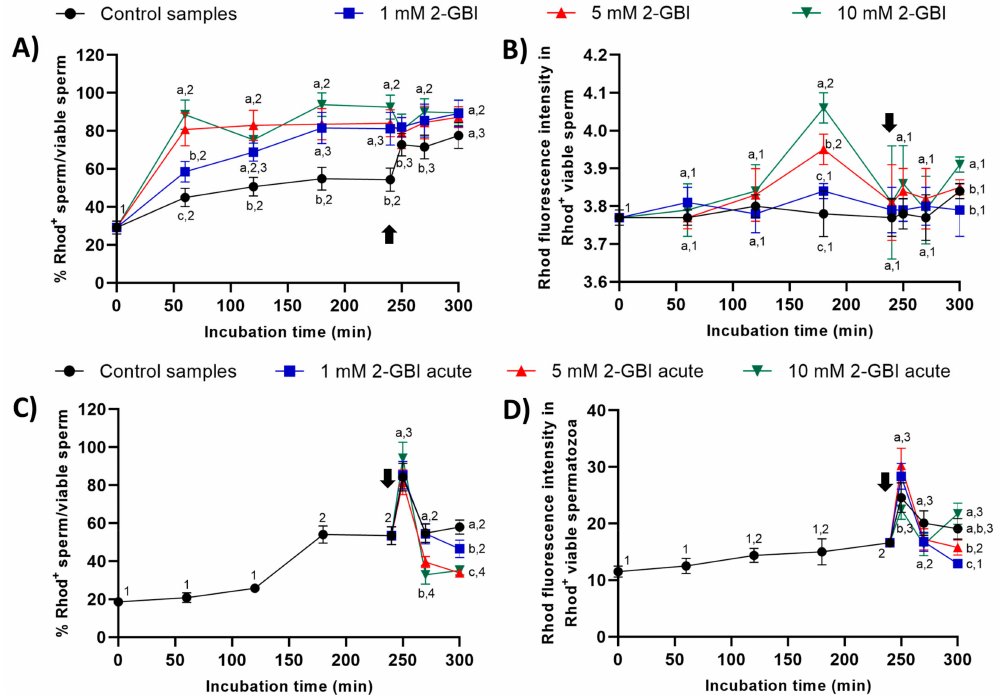
Figure 10. Percentages of viable sperm with high intracellular calcium levels evaluated through Rhod5 (Rhod5 + ) in relation to total viable sperm (YO-PRO-1 − ), and fluorescence intensity of Rhod5 + in viable sperm throughout incubation in capacitating medium (control samples) or capacitating medium plus 1 mM, 5 mM or 10 mM, added at either 0 min in experiment 1 ( A , B ) or 240 min in experiment 2 ( C , D ; acute). Di ff erent superscript letters (a–c) indicate significant di ff erences ( p < 0.05) between samples within the same time point, and di ff erent superscript numbers (1–4) indicate significant di ff erences ( p < 0.05) between time points within a given treatment. Results are expressed as mean ± SEM ( n = 10). The arrow indicates the time at which 10 µ g / mL of progesterone was added to all samples (i.e., 240 min of